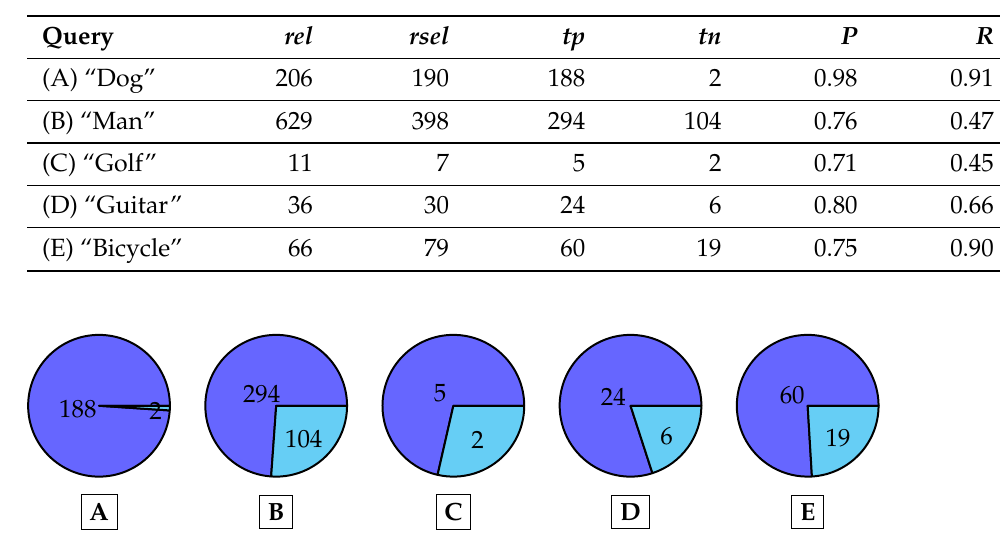
Table 4. Effectiveness of GMAF and graph code processing within 1000 random images from the Flickr30k dataset.